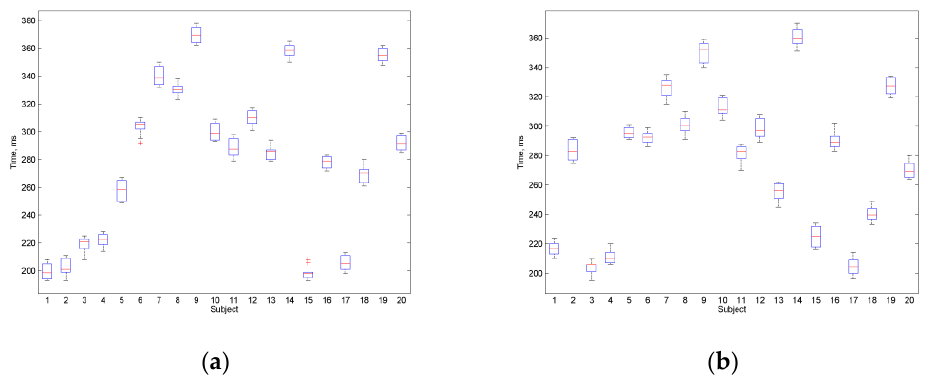
Figure 8. Subject gaze velocity: ( a ) pre-task and ( b ) post-task.